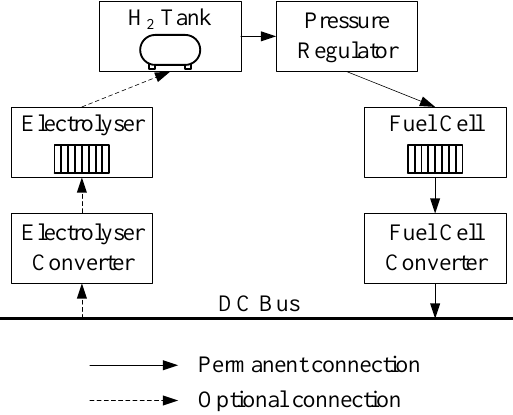
Fig. 4. Block diagram of the hydrogen energy storage